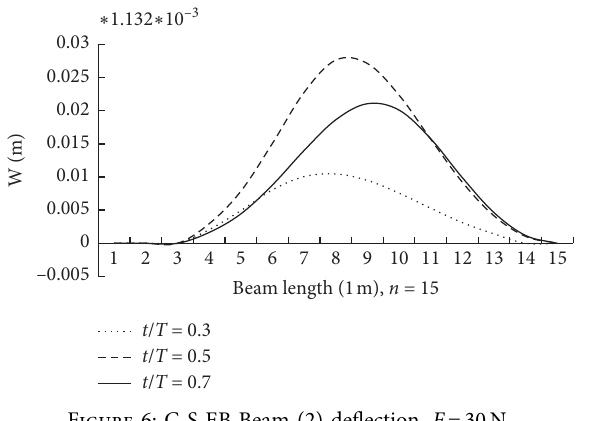
Figure 6: C-S EB Beam (2) deflection, F � 30N.